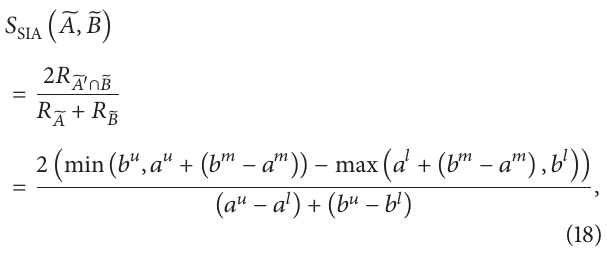
Figure 2: The intersection area of (0.4, 0.8, 0.9)